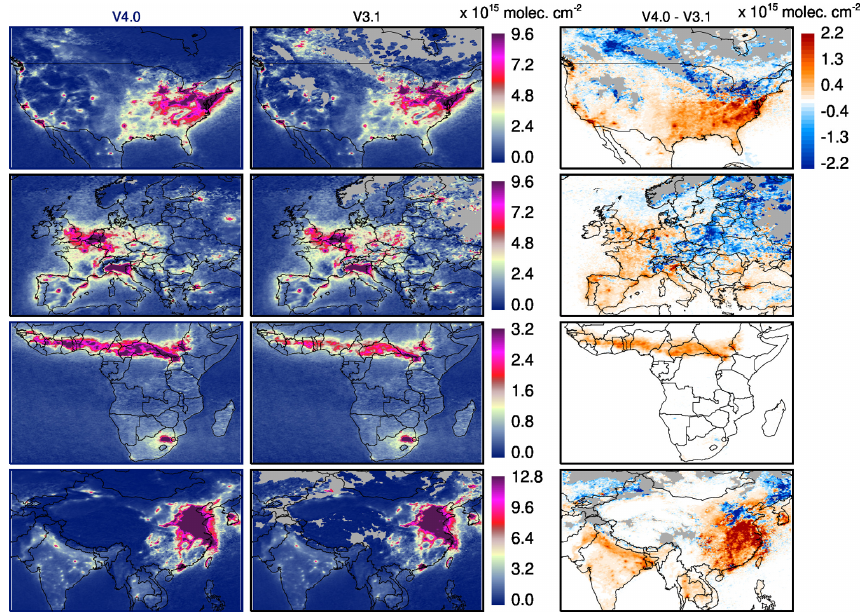
Figure 10. Same as Fig. 9, but for December, January, and February. The gray areas represent a lack of good observations as determined by data quality